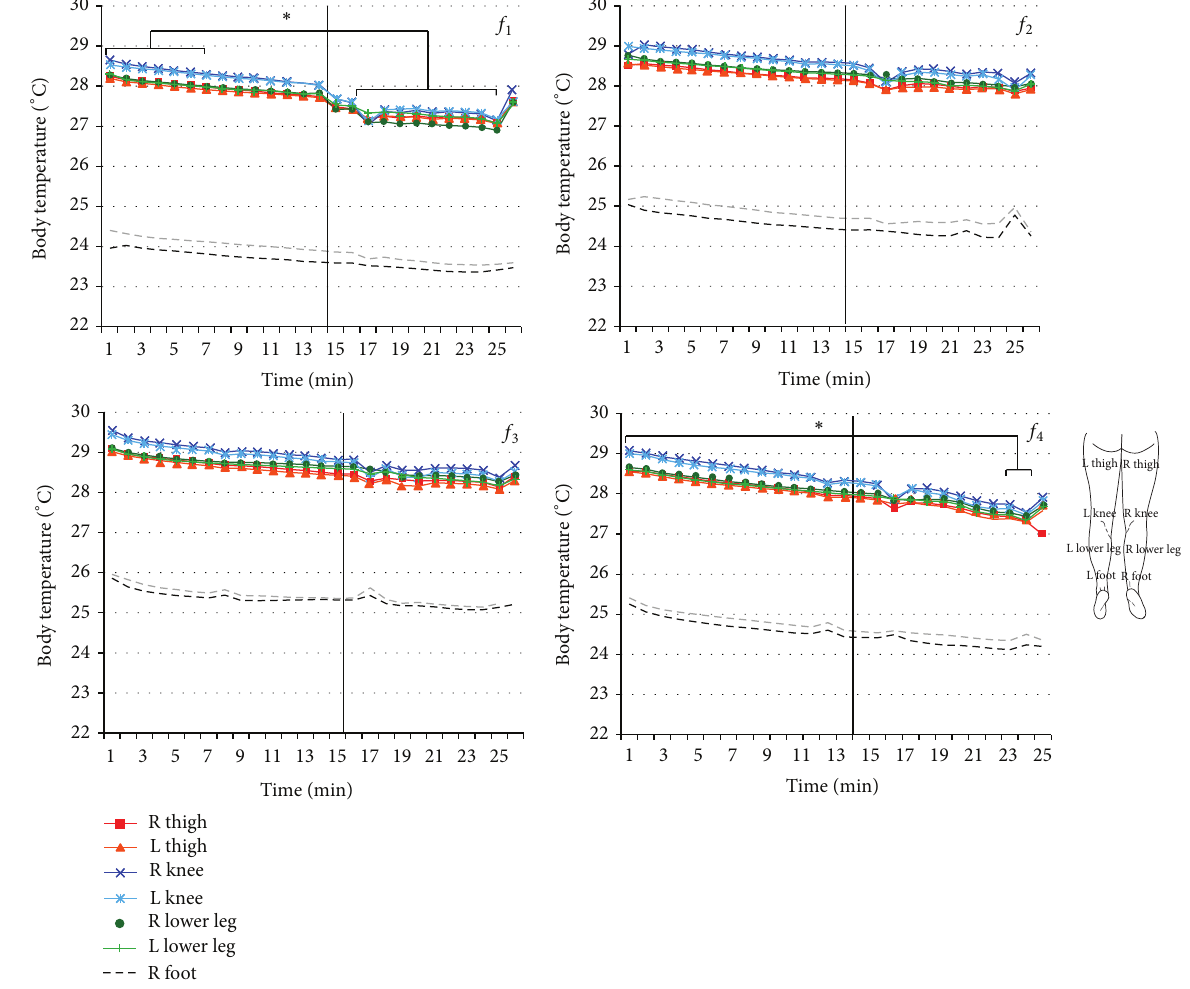
Figure 4: Thermograph curve from the posterior of the lower limbs obtained during 15 minutes of exposure and 10 minutes after exposure to four different WBV frequencies, in four regions of the right and left limbs (thigh, knee, lower leg, and foot). 𝑓 1 = 31 Hz; 𝑓 2 = 35 Hz; = 40 Hz; 𝑓 = 44 Hz ( 𝑛 = 24 ) ( ∗ 𝑃 < 0.05 𝑓 3 4